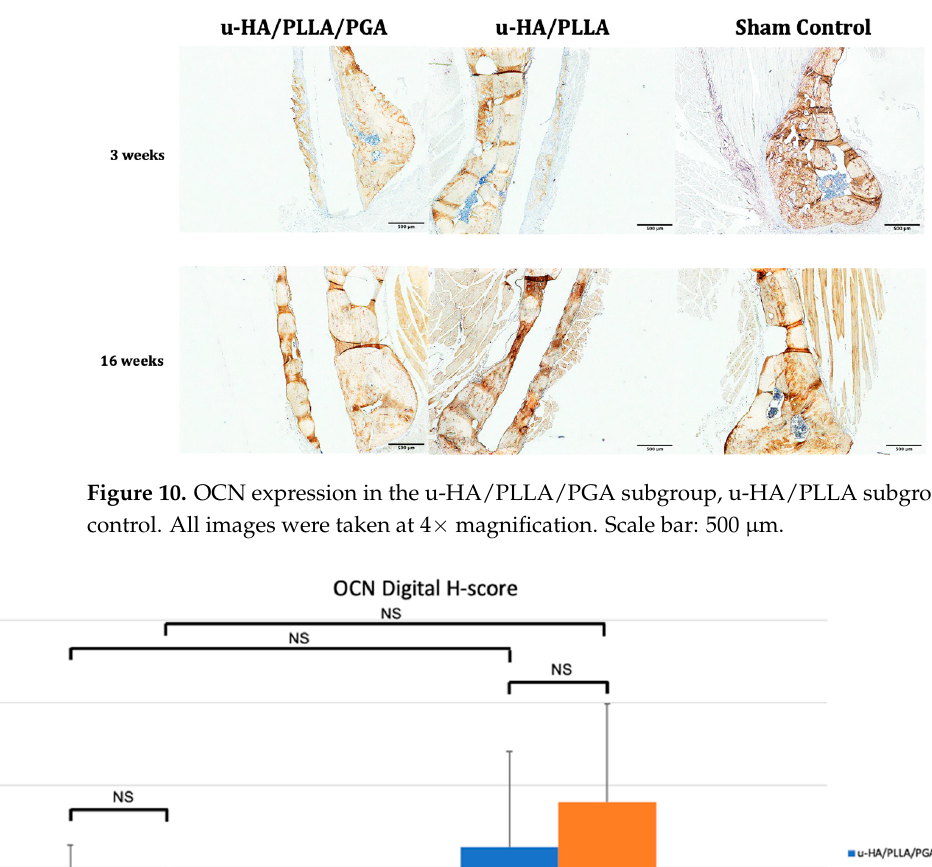
observed higher OCN expression in newly formed bone (Figure 10).